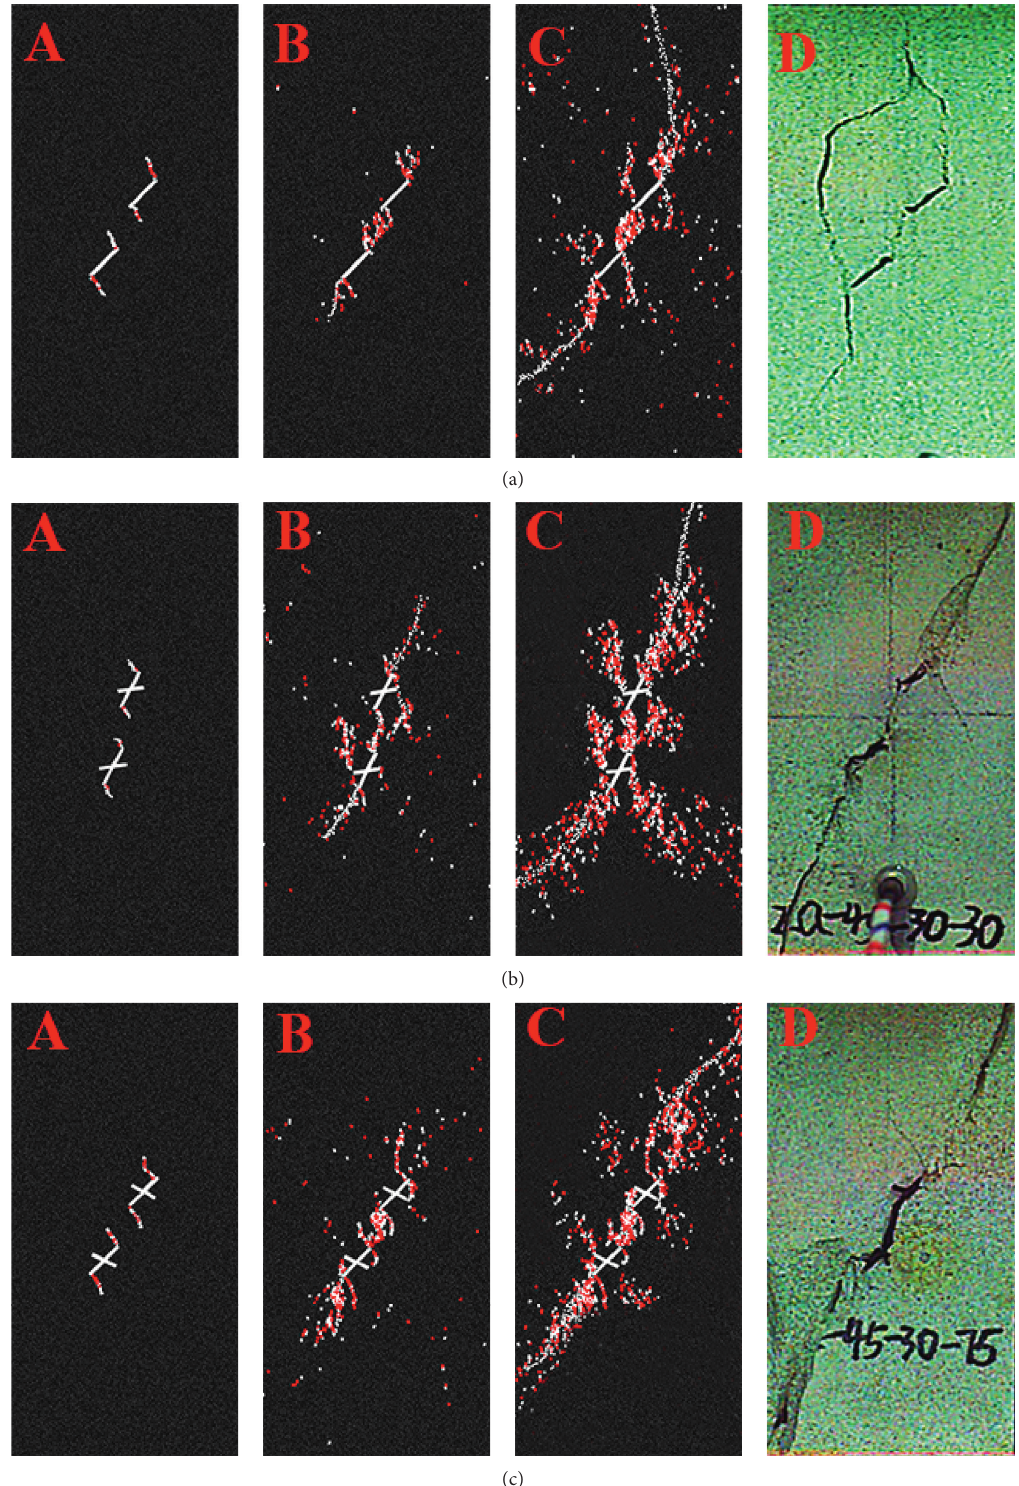
Figure 11: Figures of the crack propagation process in the FJM model (red and white colors indicate shear and tensile cracks, respectively) and experiments for c . (a) c � 0 ° . (b) c � 30 ° . (c) c � 75 °